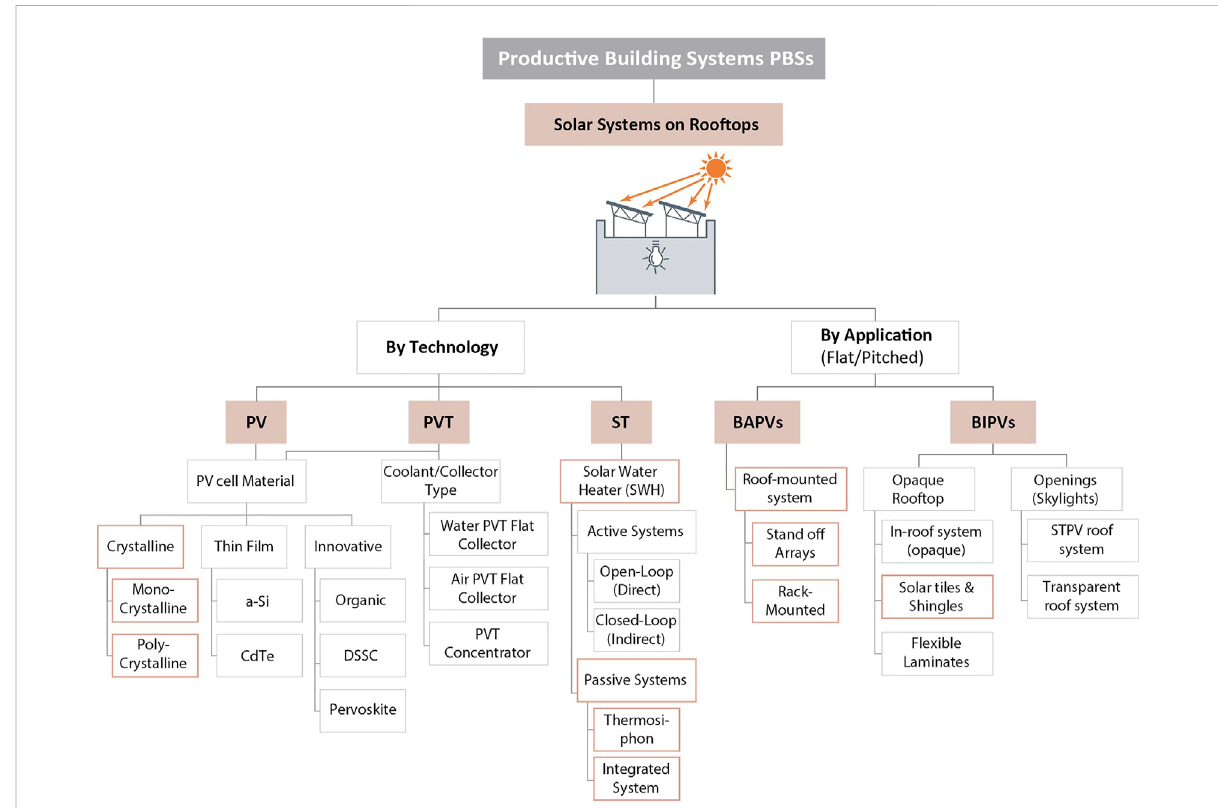
FIGURE 7 Inventory of solar energy systems (BAPVs and BIPVs) on rooftops, compiling the types and classi fi cations identi fi ed from assessed studies and reports to create thebody of classi fi cation (all boxes).Structured based on (Stephenand James, 2001;Tyagi et al.,2012; Tripathy etal., 2016;Ghosh, 2020; Reddy et al., 2020; Dehghan et al., 2021; Singh et al., 2021) with additions. Systems existing in the Egyptian market are highlighted by the brown-bordered boxes. PBSs, Productive Building Systems; BAPVs, Building-Applied Photovoltaics; BIPVs, Building-Integrated Photovoltaics; PVs, Photovoltaic panels; PVTs, Photovoltaic thermal systems; STs, Solar Thermal systems; SWH, Solar Water Heaters; a-Si, Amorphous silicon cells; CdTe, Cadmium telluride cells; DSSC, Dye-synthesized solar cell; STPV, Semi-Transparent